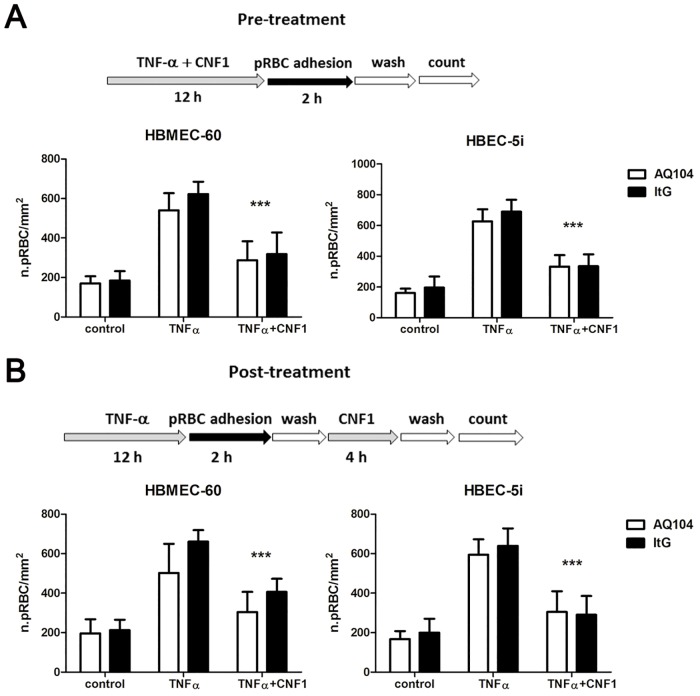
CNF1 decreases P. falciparum endothelial cytoadherence.HBMEC-60 and HBEC-5i endothelial cells were tested in two different experimental conditions: (A) overnight pre-incubation with CNF1 before the adhesion process of pRBCs (pre-treatment assay) and (B) treatment with CNF1 for 4 h, after the adhesion assay (post-treatment assay). CNF1 was able either to prevent parasite citoadherence (A) or to induce parasite detachment (B), in both cell lines and with both P. falciparum clones ItG and AQ104. pRBC bound were expressed as raw numbers of pBRC per mm2. Data represent mean ± SEM from at least three experiments. *** p<0.001, **p<0.01, *p>0.05.